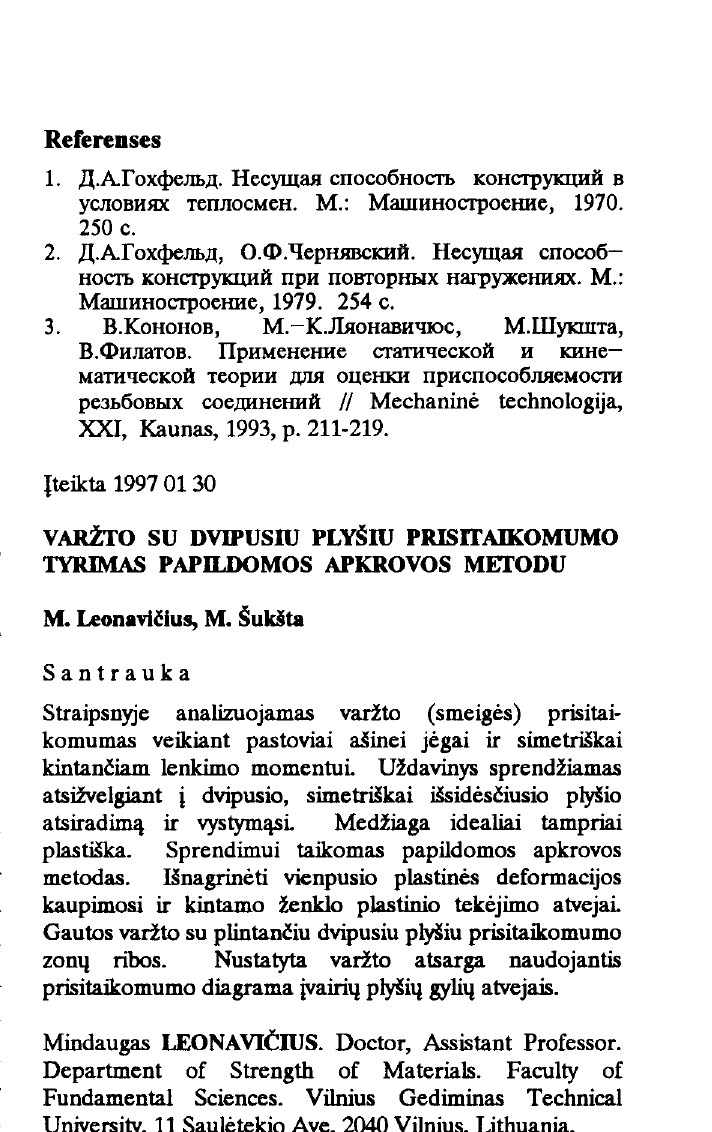
Fig. 3. limit diagram for case, when k=O The reserve coefficient is identified from